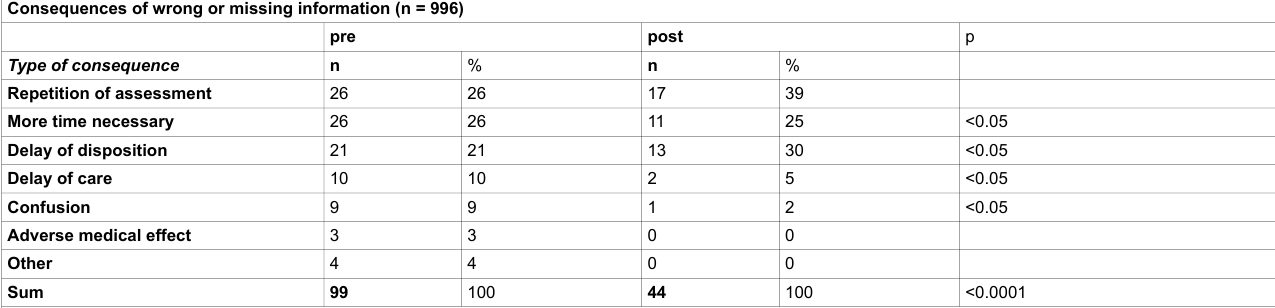
Pre = pre-interventional handovers, post = post-interventional handovers, n = number of incidences per handover session; each category could be mentioned only once per patient. Chi square and Fisher’s exact